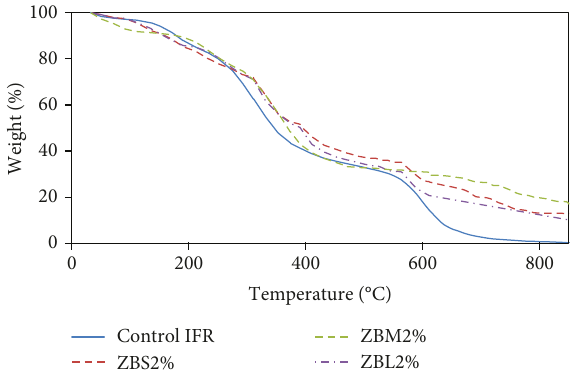
Figure 14: TG curves of IFR/ZB coatings (under air).